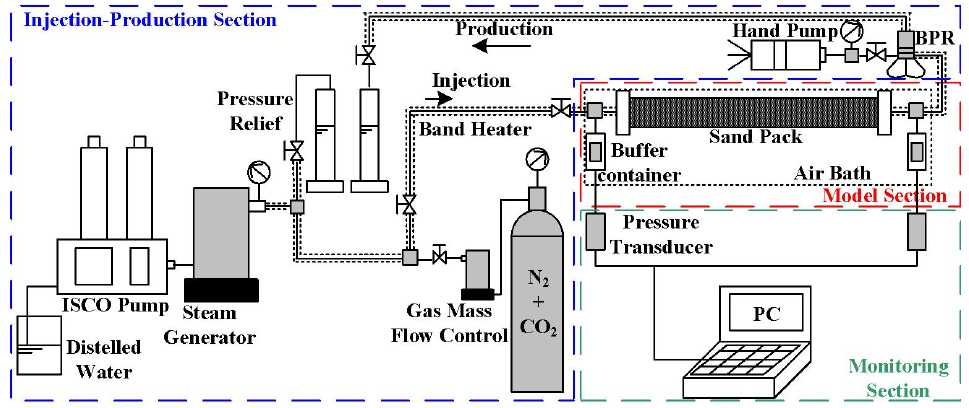
Figure 5. Flow chart of one-dimensional flooding